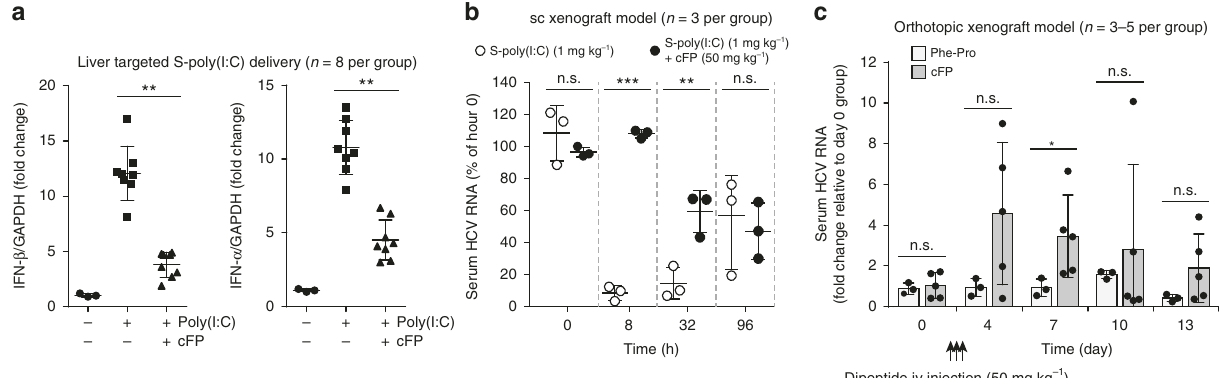
Fig. 6 Suppression of type I IFN production by cFP and its impact on HCV replication in mice. a cFP in 100- μ l saline was injected into tail veins of BALB/c mice (8 weeks old, n = 8) at a dose of 50 mg cFP per kg of body weight. After 1 h, poly(I:C) formulated in lipidoid nanoparticles (100 μ l) was administered through the tail vein at a dose of 1 mg per kg body weight. After 8 h stimulation, IFN- α / β mRNA levels were analyzed using total RNA extracted from the large lobe of mouse liver. b , c Quanti fi cation of serum HCV RNA titers in mouse models of HCV replication. In b , NOD/SCID mice carrying s.c. HCV- infected Huh7 xenografts (9 weeks old, n = 3 per group) were pre-treated with cFP for 1 h prior to poly(I:C) stimulation, as described in a . In c , an orthotopic mouse model with a chimeric liver transplanted with HCV-infected Huh7 was used (9 weeks old, n = 3 – 5 per group). After three consecutive cFP or Phe-Pro injections (50 mg per kg body weight once a day for 3 days) starting on day 1, serum HCV RNA loads were monitored. All data were presented as a fold-change relative to the groups which received Phe-Pro. In all panels, error bars are standard deviations. In a , data are from three independent experiments, each involving triplicate assays. Statistical signi fi cance of differences between groups was determined via unpaired two-tailed t - test ( b ) or Welch ’ s t -test ( c ). * P < 0.05; ** P < 0.01; *** P < 0.001; n.s., not signi fi